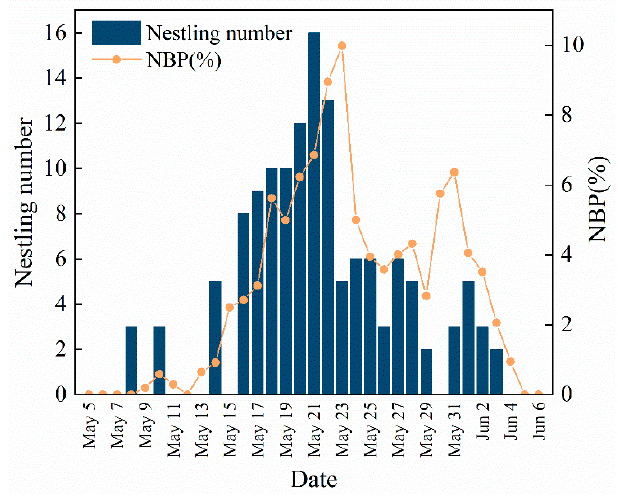
Figure 1. Daily nymph biomass proportion (NBP) and the number of newborn Asian short-toed lark ( Alaudala cheleensis ) nestlings. NBP is the proportion of the daily grasshopper nymph biomass relative to the total biomass measured on all survey days.